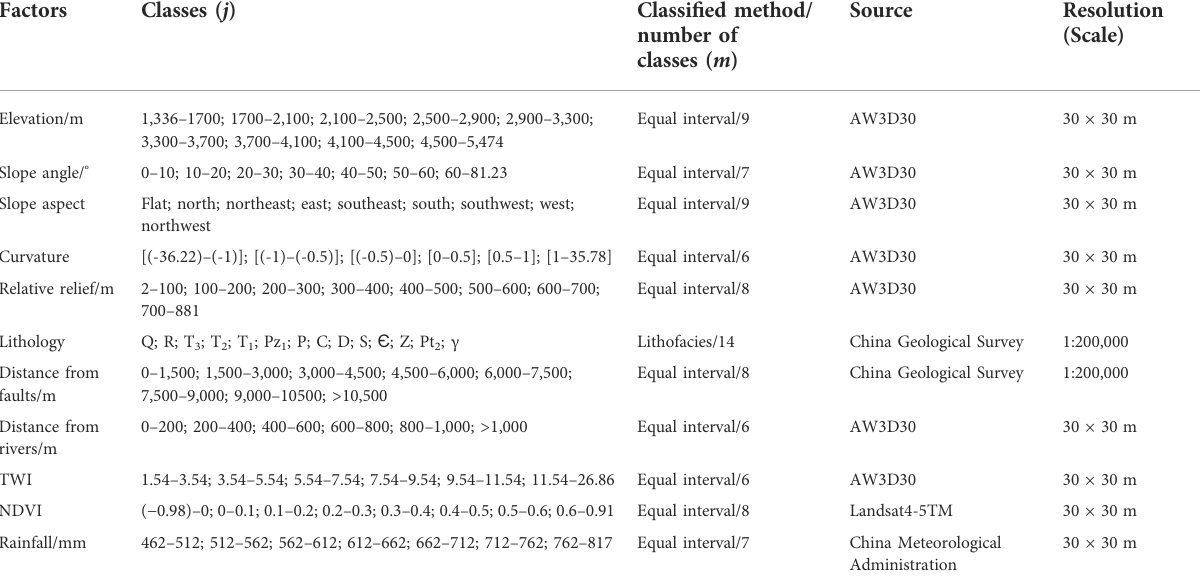
TABLE 1 The spatial database used for modeling and